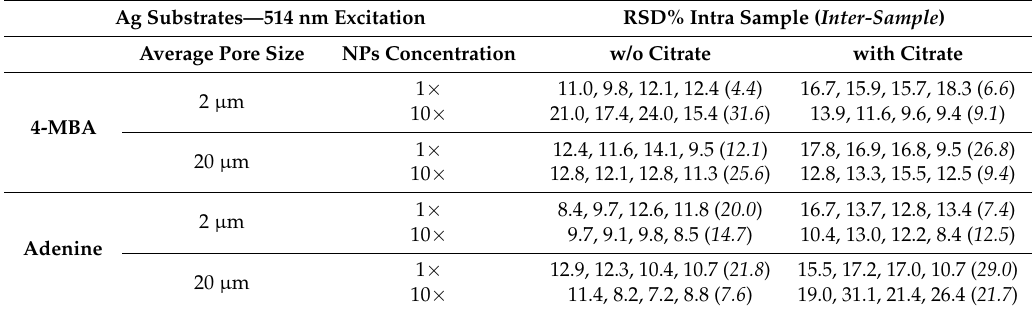
Table 2. Intra- and inter-sample Relative Standard Deviations (RSD) of the 4-MBA band area (1550~1615 cm − 1 ), and of the adenine band area (700~770 cm − 1 ), calculated from SERS maps for Ag substrates excited at 514 nm.